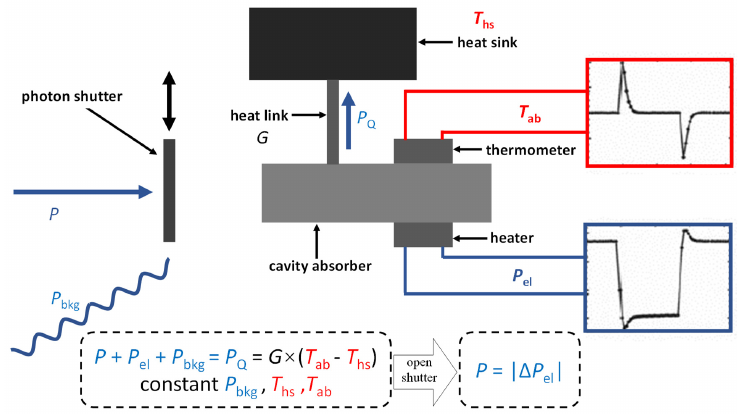
Figure 2. Operating principle of the CESR. Red symbols indicate status of temperature, and blue symbols indicate the flow of power.